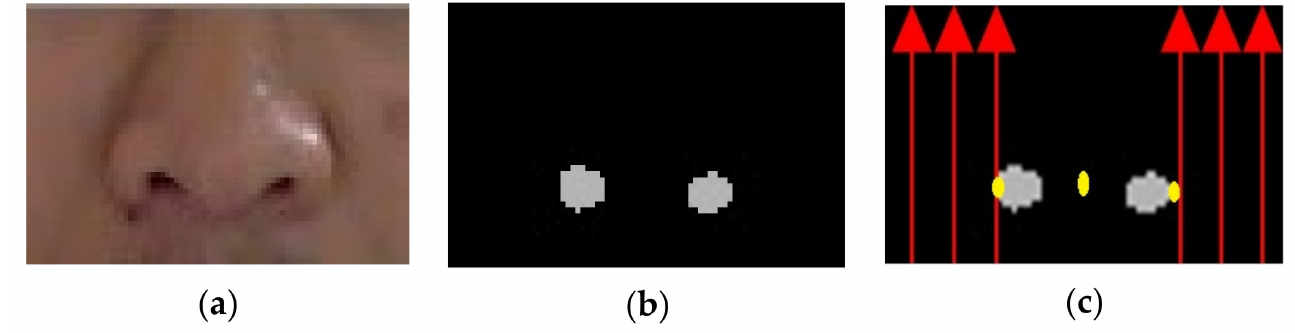
Figure 5. Projection technique to find landmarks of the nose: ( a ) extracted nose ROI; ( b ) binarized nose ROI; ( c ) vertical projection.